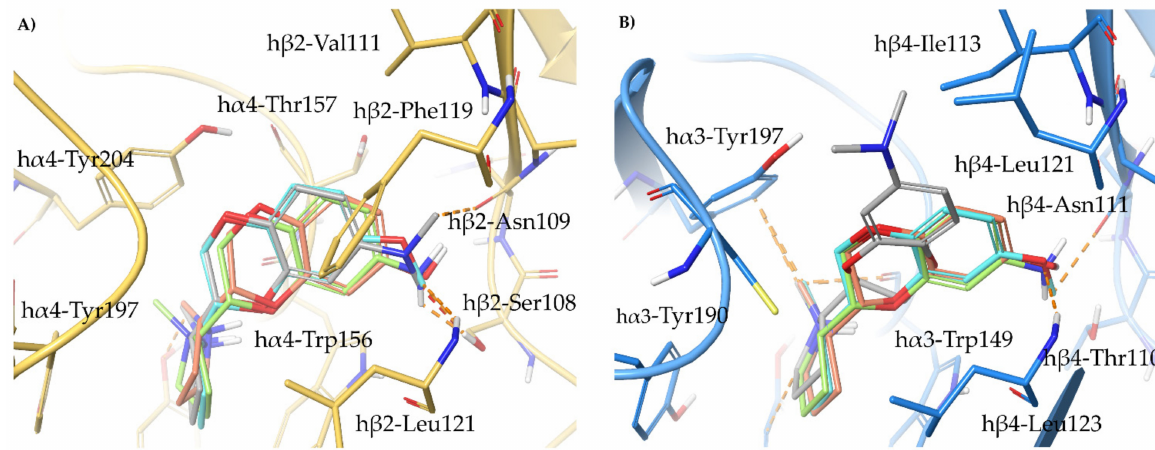
Figure 9. Binding poses of the high affinity ligands ( S , R )- 2 (faded orange), ( S , R )- 29 (yellow-green), and of the weak binders ( S , R )- 26 (cyan), ( S , R ) - 31 (grey) at the ( A ) h α 4 β 2 nAChR (adapted from 6CNJ, yellow residues and backbone cartoons) and at the ( B ) h α 3 β 4 nAChR (adapted from 6PV7, light blue residues and backbone cartoons). Unfavorable and very unfavorable steric clashes are depicted with orange and red dashed lines,